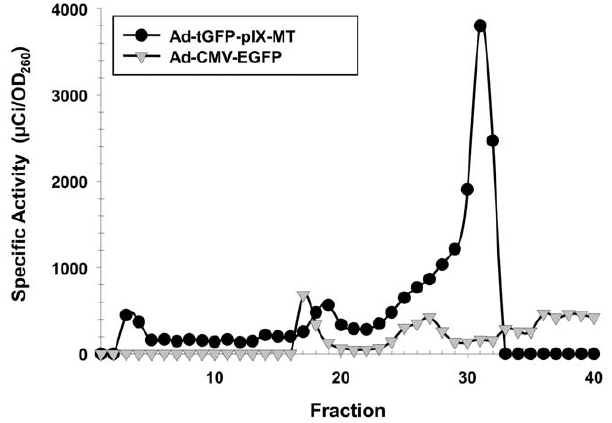
Figure 4. Gel filtration column profile of 99mTc binding to adenovirus containing a pIX-MT fusion protein. After incubation with 99m Tc glucoheptonate, the Ad-tGFP-pIX-MT virus containing a pIX- MT fusion protein and the Ad-CMV-EGFP virus containing a wild-type pIX protein were purified by gravity gel filtration using 20 mL Sephacryl S-200 columns. Each point represents the specific activity in mBq/v.p of individual 10 drop fractions collected.